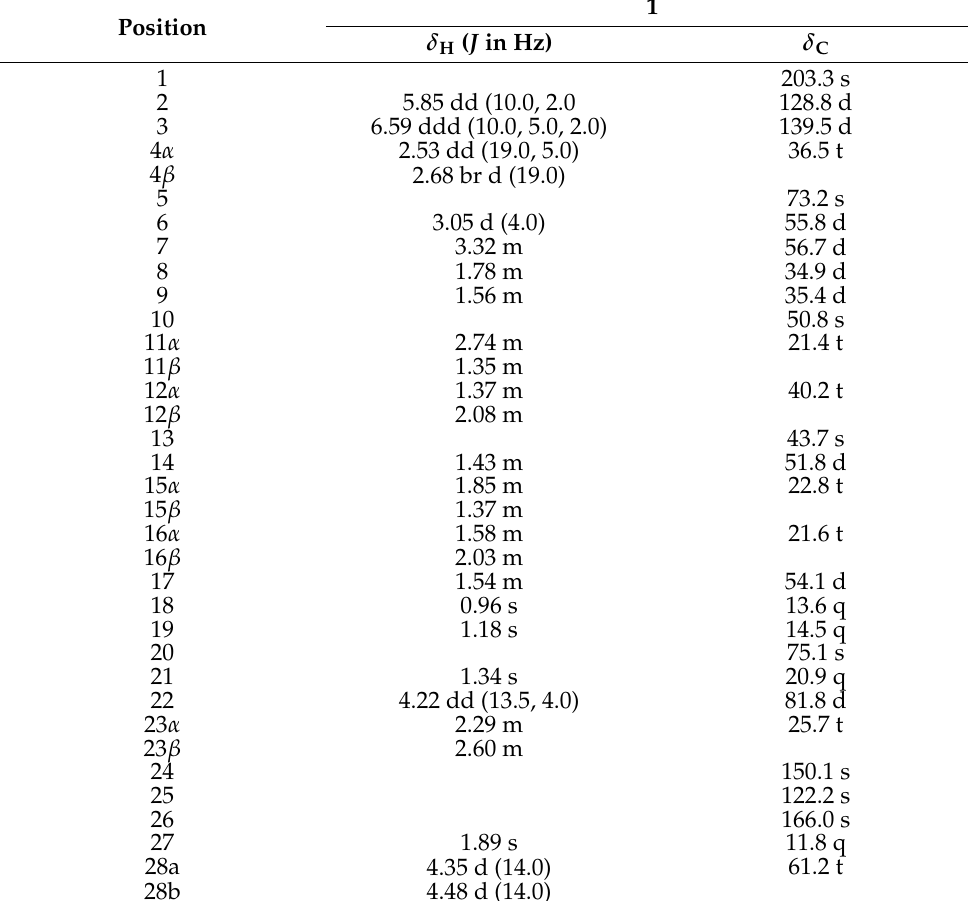
Table 1. 1 H (800 MHz) and 13 C NMR (200 MHz) data of compound 1 in CDCl 3 ( δ in ppm) a .